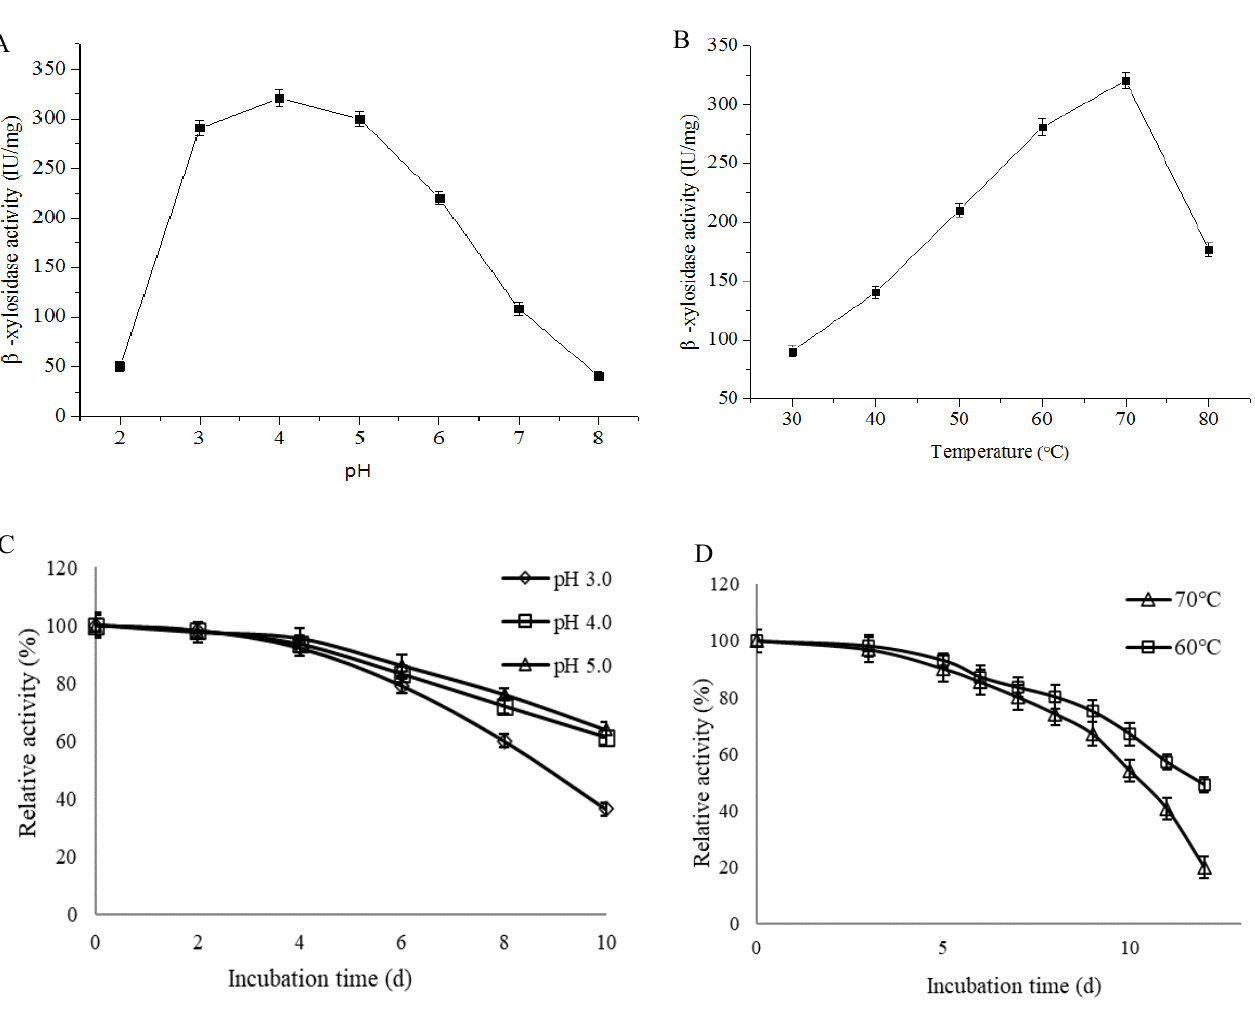
Figure 5. Optimum ( A ) pH and ( B ) temperature of PpBXL. ( C ) pH and ( D ) temperature stabilities of PpBXL.